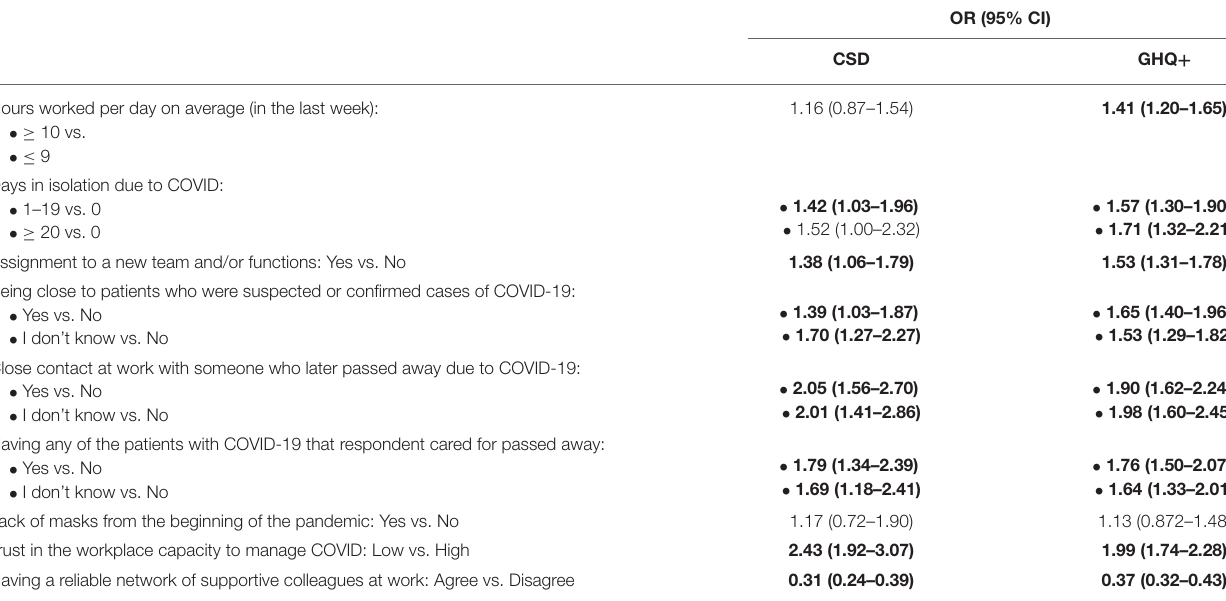
TABLE 6 | Association between health workers workplace-level factors and CSD (PHQ-9 ≥ 15) or GHQ + (GHQ-12 ≥ 4).